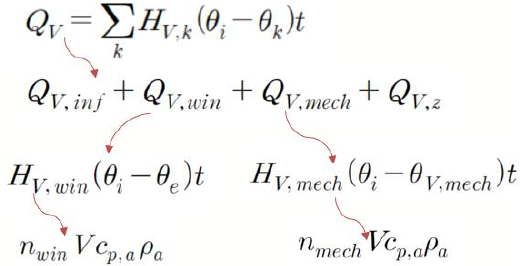
Figure 2. Ventilation heat loss calculation Formulas (2) – (13) in DIN V 18599 part